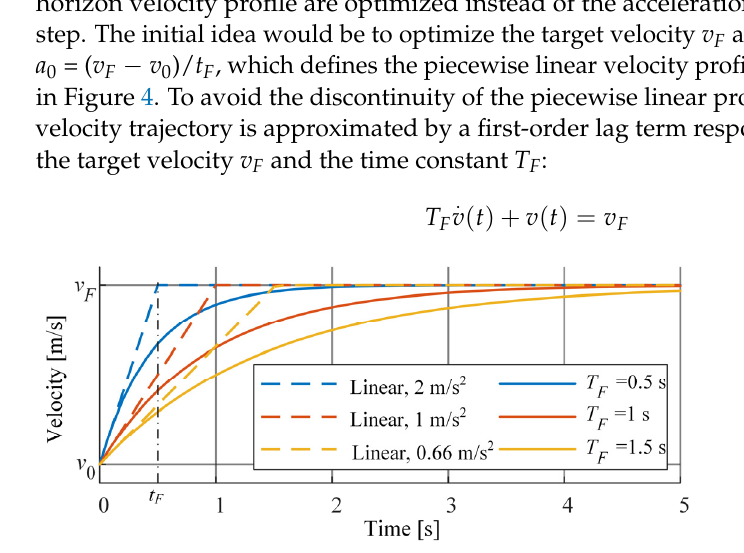
Figure 3. Illustration of full control horizon ( a ), limited control horizon ( b ), and move-blocking strat- egies ( c ).